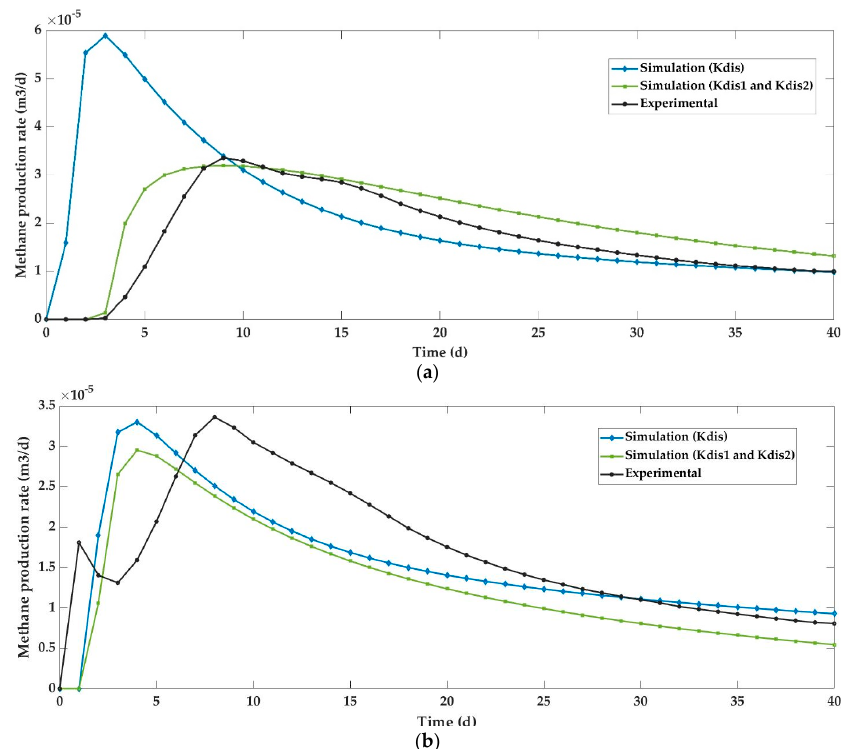
Figure 7. Methane production rate of simulation and experimental results: RF ( a ) and CF ( b ).